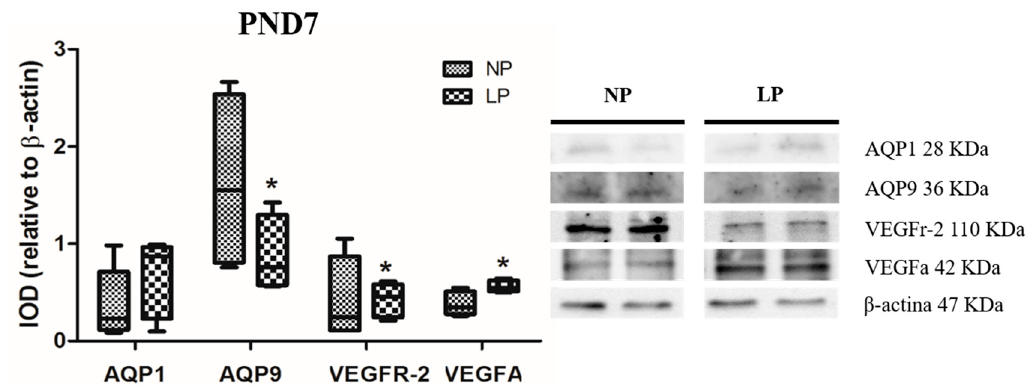
Figure 2. Expression of AQP1, AQP9, VEGFr-2 and VEGFa in the epididymis of NP and LP animals at PND7. Data are expressed as the mean ± S.E.M. * p < 0.05. Mann–Whitney test.